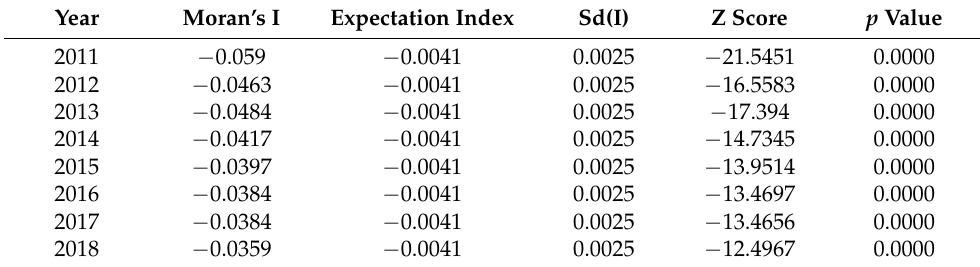
Table 4. Moran’s I of the Degree of Digital-Economy Development (2011–2018).